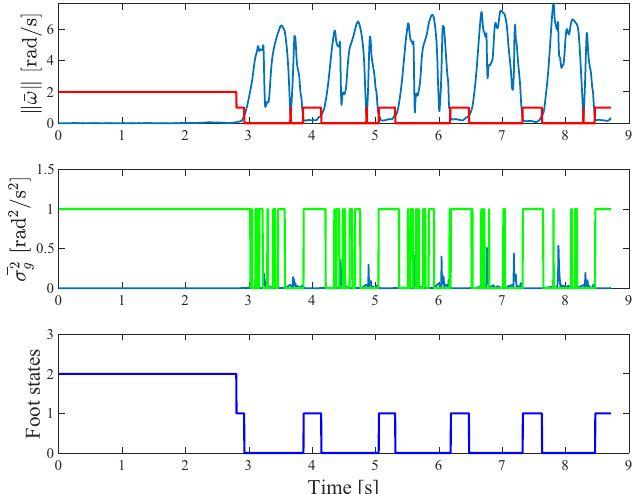
Figure 3. Results of foot-state detection. From top to bottom, top subfigure: detection results satisfying the angular rate energy condition (the red line shows the detection results, where 2 is the still phase, 1 is the stance phase, and 0 is the swing phase); middle subfigure: detection results satisfying the angular rate variance condition (the green line shows the detection results, where the high level indicates the still and stance phases and the low level indicates movement); bottom subfigure: the final detection results satisfying both conditions (2 is the still phase, 1 is the stance phase, and 0 is the swing phase).